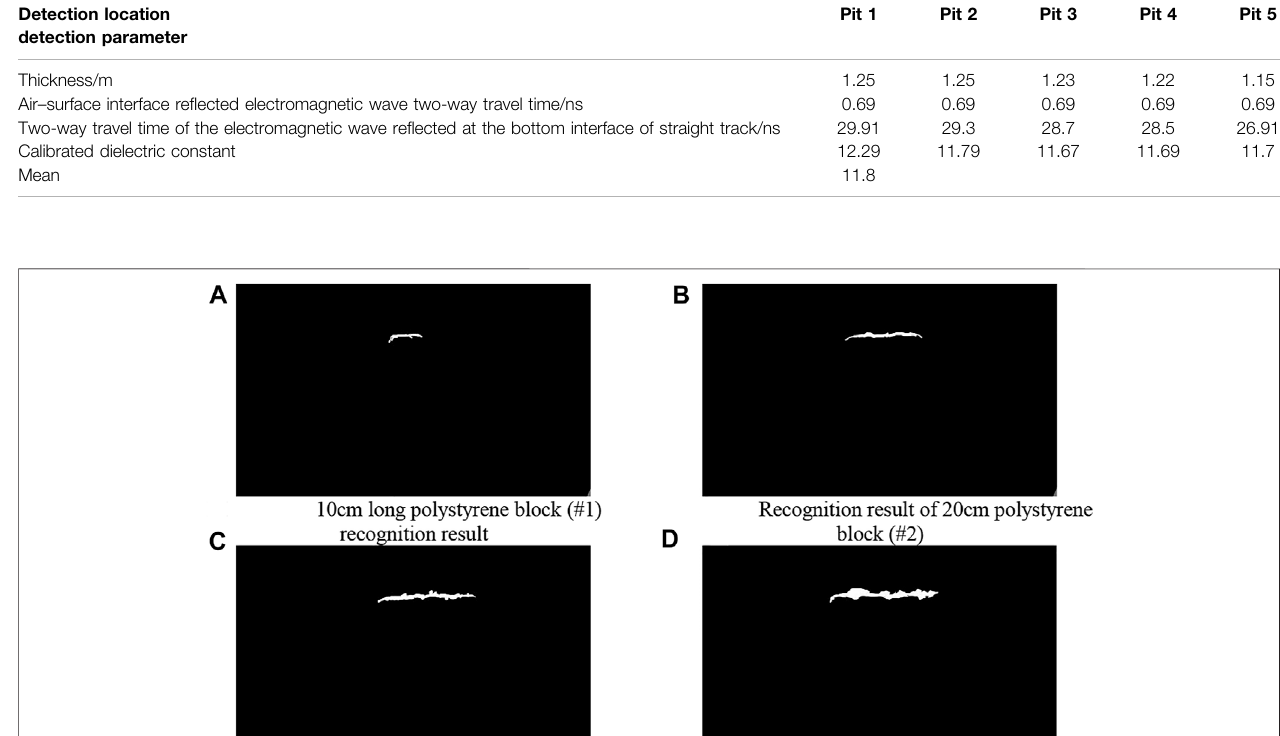
Frontiers in Materials |